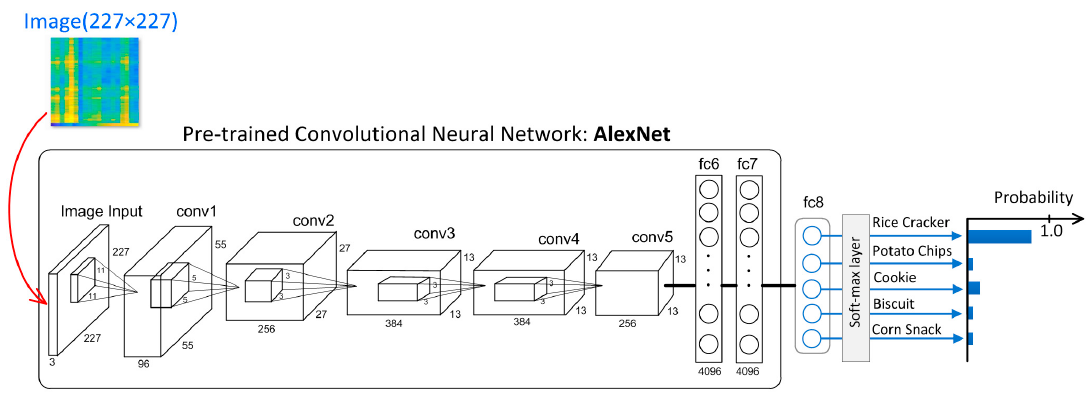
Figure 15. Convolutional neural network (CNN) for classifying snacks.